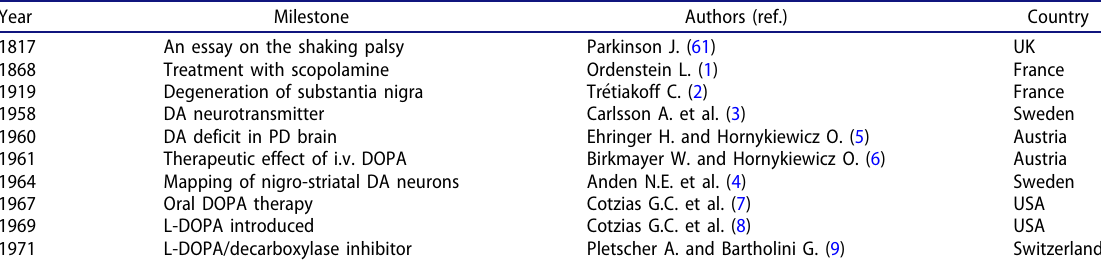
Table 1. Milestones in Parkinson ’ s disease